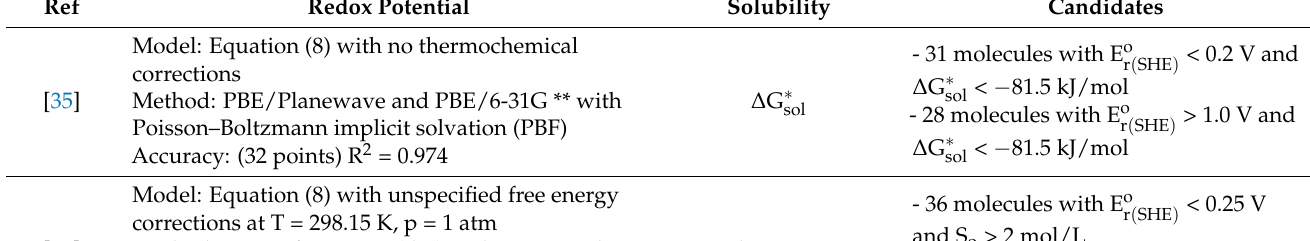
Table 4. Summary of the methods used for redox potential and solubility prediction in available HTVS literature, along with the number of screened candidates and their respective criteria. Solubility